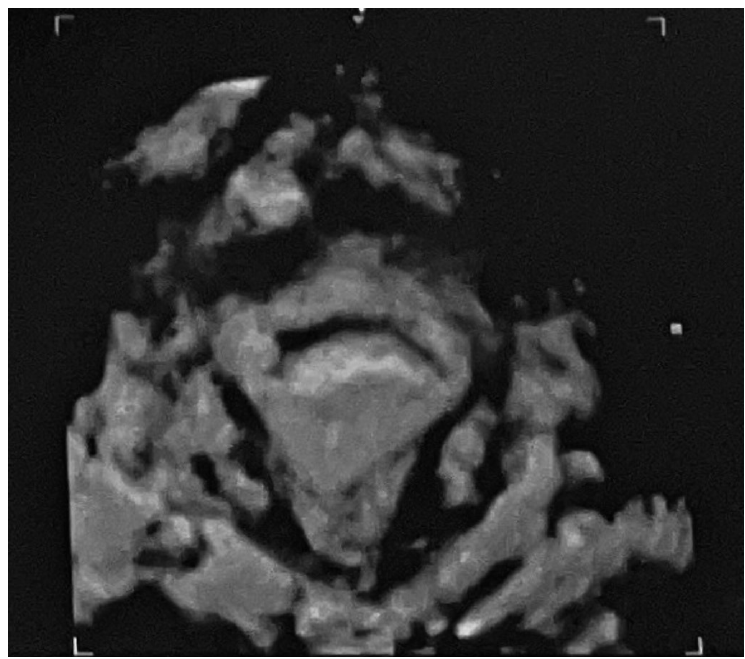
Figure 2. 3D transvaginal ultrasound showing the interstitial pregnancy.